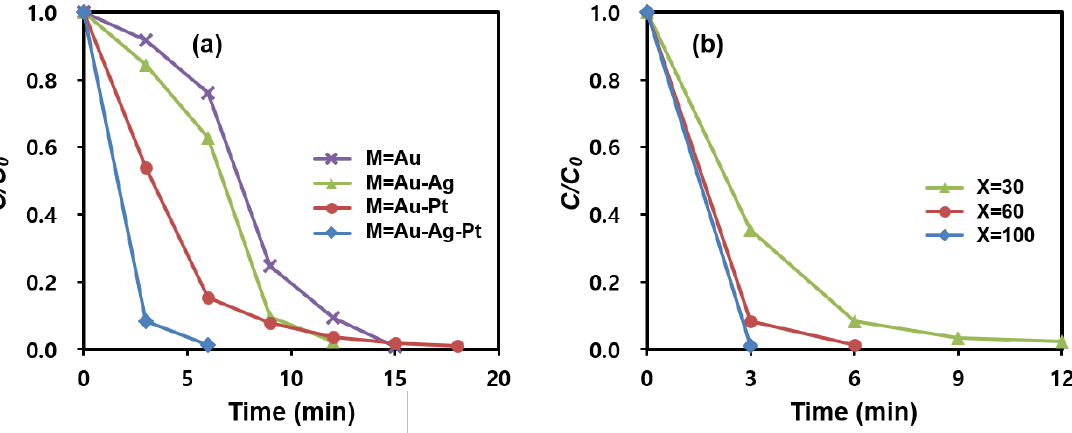
Figure 6. Catalytic reduction rates of 4-NPh to 4-APh by ( a ) MNP@PD 60 /M/IO (M = Au, Au-Ag, Au- Pt, and Au-Ag-Pt) and ( b ) MNP@PD x /Au-Ag-Pt/IO (x = 30, 60, and 100). Au-Pt, and Au-Ag-Pt) and ( b ) MNP@PD x /Au-Ag-Pt/IO (x = 30, 60, and MNP@PD/Au-Ag-Pt/IO particles with various PD layer thicknesses were tested for